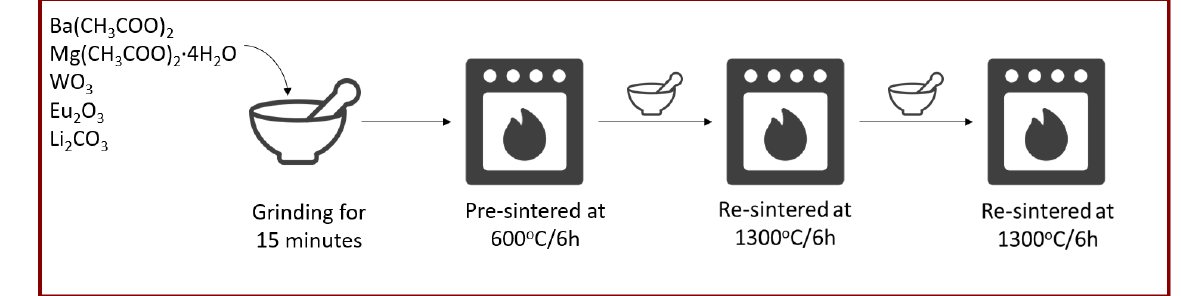
Figure 1. Solid-state synthesis scheme for obtaining polycrystalline BMW:Eu powders.